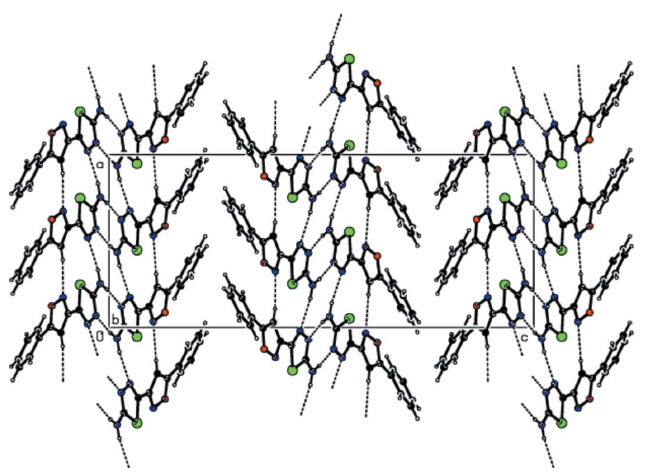
Figure 4 Aview of the intermolecular N—H (cid:2)(cid:2)(cid:2) N and C—H (cid:2)(cid:2)(cid:2) N interactions in the crystal structure of the title compound projected along the b axis.